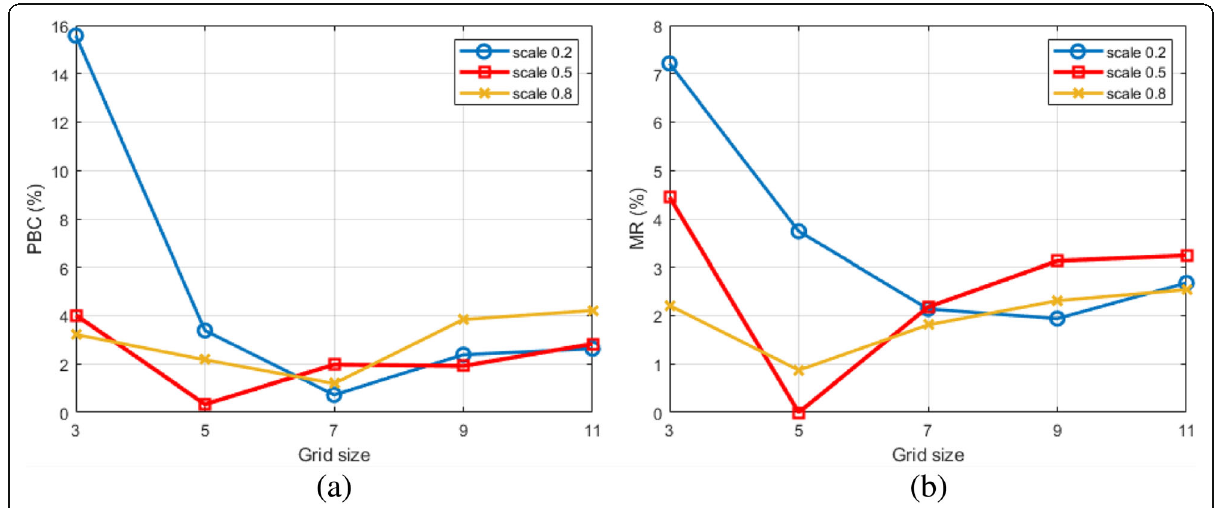
Fig. 3 Performance comparison for choosing the optimal CDAS parameters in terms of ( a ) PWC and ( b )